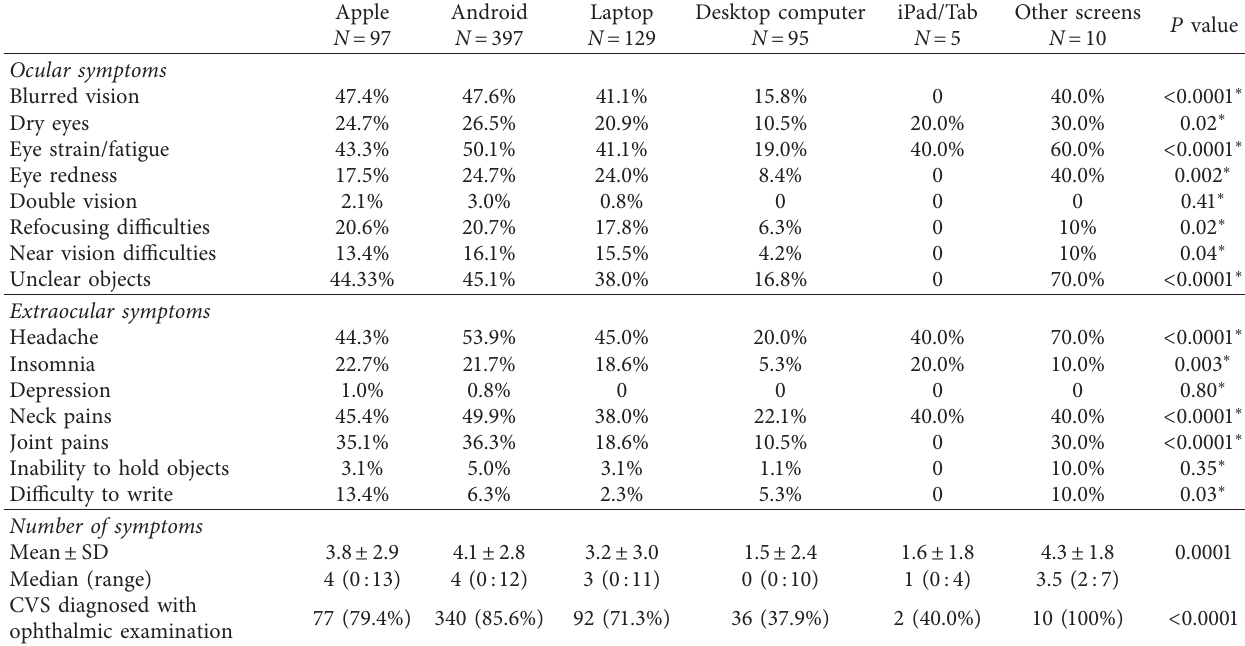
Table 1: Relationship between symptoms and type of commonest/primary screen